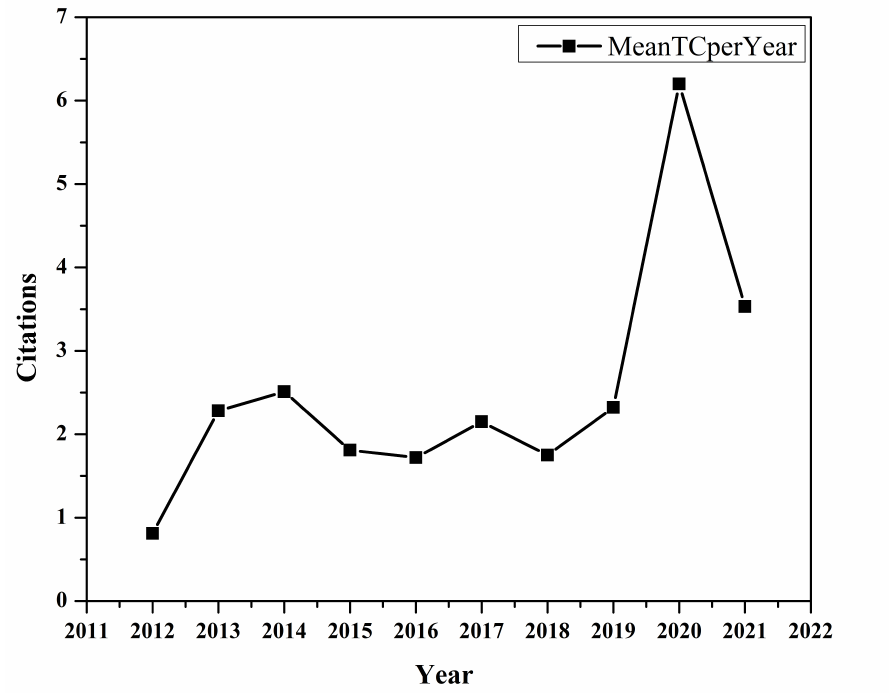
Figure 2. Average Citation Per Year.